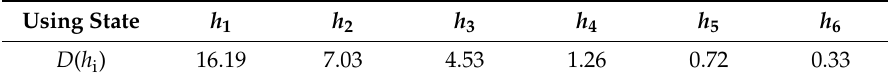
Table 3. The duration of each using state.